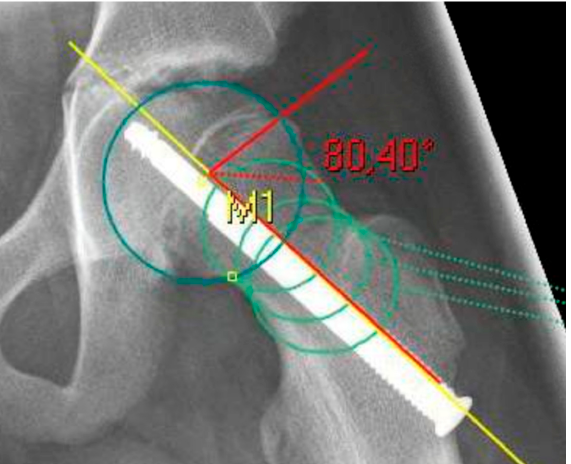
Figure 1. X-ray after screw fixation of a left sided SCFE as an example for the measurement of the alpha angle. The femoral neck axis (yellow line) was determined with three circles (light green) according to Bouma [29].